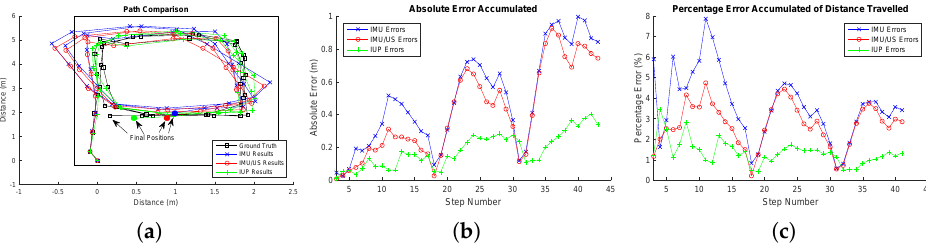
Figure A1. ( a ) The tracked walking paths by the inertial measurement unit (IMU), IMU/ultrasound (US) and inertial/ultrasound/particle filter (IUP) systems for trial 2 of Type 1 walking compared to the ground truth position measured simultaneously by a Vicon motion capture system. ( b ) The absolute errors of the IMU, IMU/US and IUP systems at each single step for trial 2 of Type 1 walking. ( c ) The percentage errors of the IMU, IMU/US and IUP systems at each single step for trial 2 of Type 1 walking.